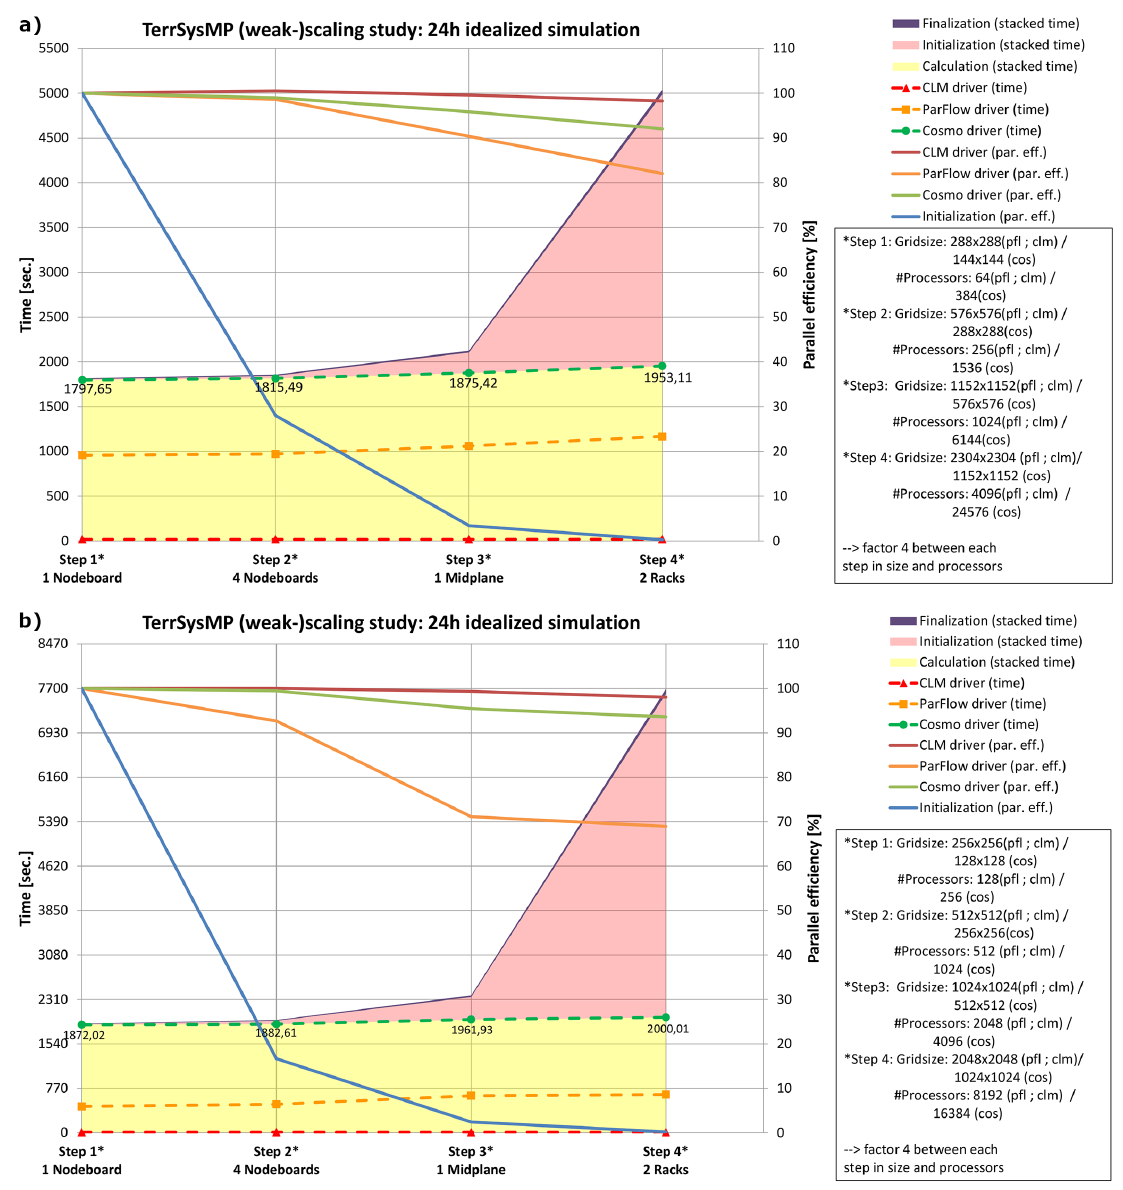
Figure 5. Idealized TerrSysMP weak-scaling study results with (a) setup design 1 ( nx = ny = 288, 288, and 144 for ParFlow, CLM and COSMO, respectively) and (b) setup design 2 ( nx = ny = 256, 256, and 128 for ParFlow, CLM and COSMO, respectively). The dotted lines show the absolute timings of the individual component models (green/COSMO is bounding the calculation time). The colored areas show the stacked absolute timings of the calculation, initialization and finalization time. The solid lines show the parallel efficiency of the relevant components on the secondary axis. The computational problem size, n , as well as the assigned CPU cores, np, is increasing by a factor of 4 between each